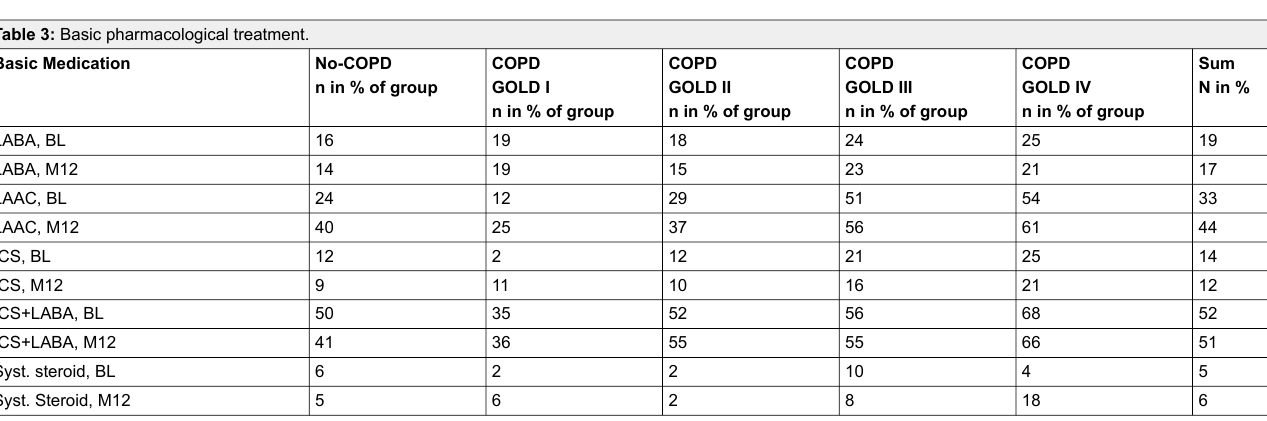
Table 3: Basic pharmacological treatment. Basic Medication